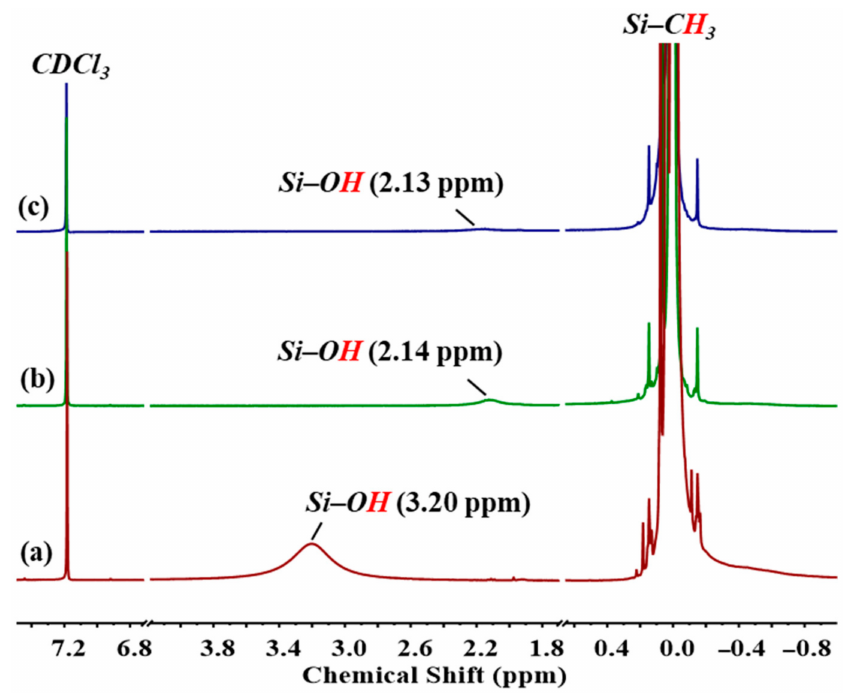
Figure 4. 1 H-NMR spectra of ( a ) Silanol 5.3 , ( b ) Silanol 22.5 , and ( c ) Silanol 56.2